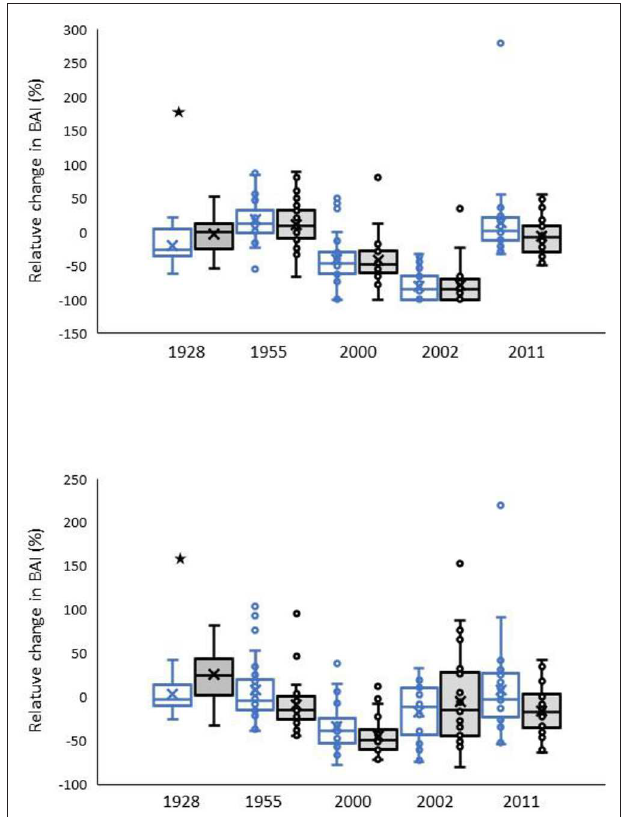
FIGURE 5 | Indices of drought sensitivity, DS (Top) , and drought recovery, DR (Bottom) . Indices reflect the proportional anomaly in BAI calculated in 3-year windows before drought (DS) or 3 years pre- and 3 years post-drought (DR). Pinus leiophylla open symbols, P. ponderosa shaded symbols. Stars indicate significant differences between the